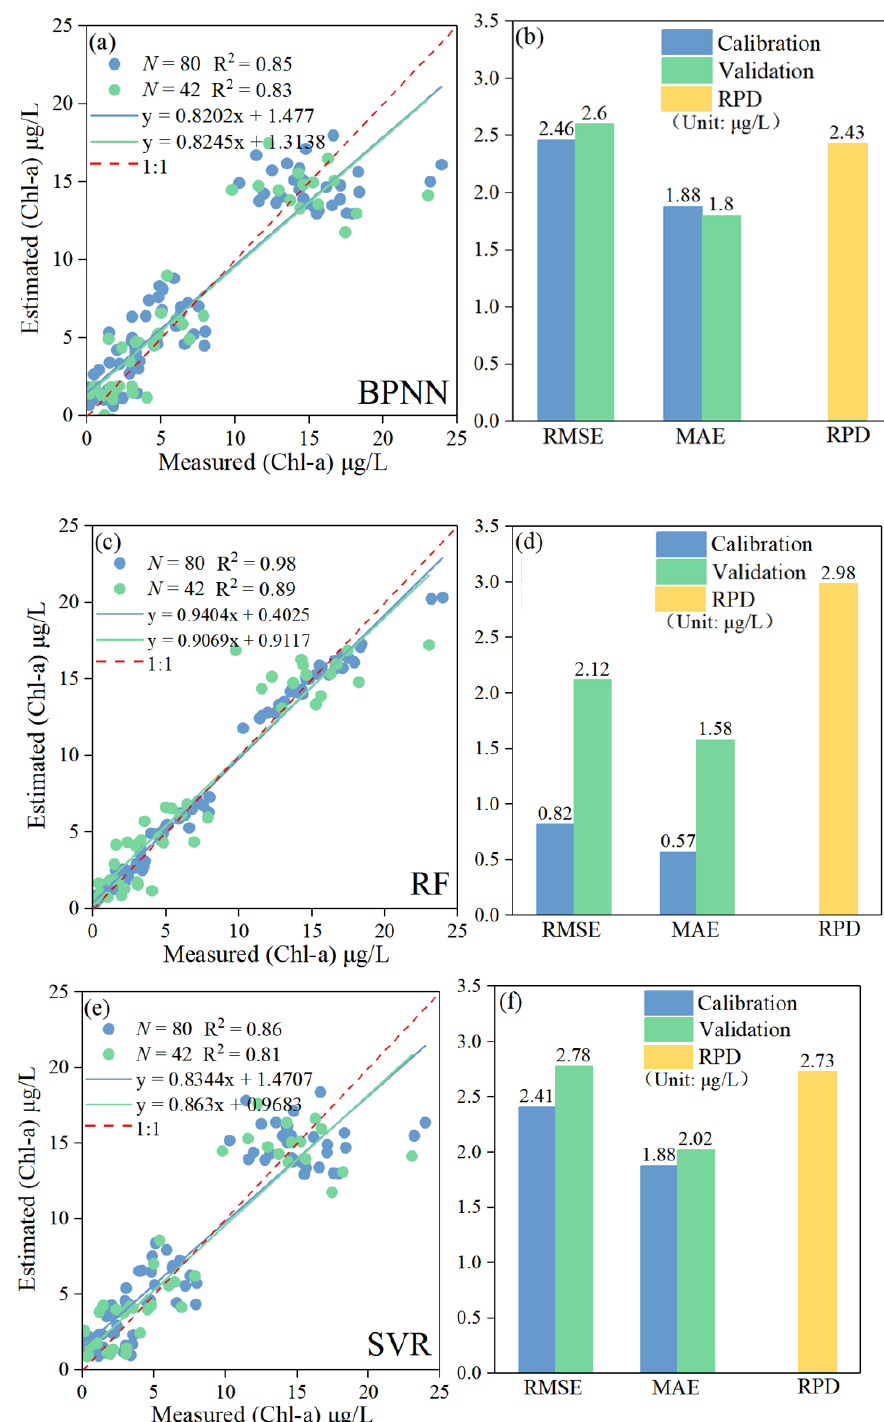
Figure 5. Relationships between the measured and estimated Chl-a for both model training and testing samples by the back propagation neural network ( a ) and its errors ( b ), random forest ( c ) and its errors ( d ), and support vector regression ( e ) and its errors ( f ).